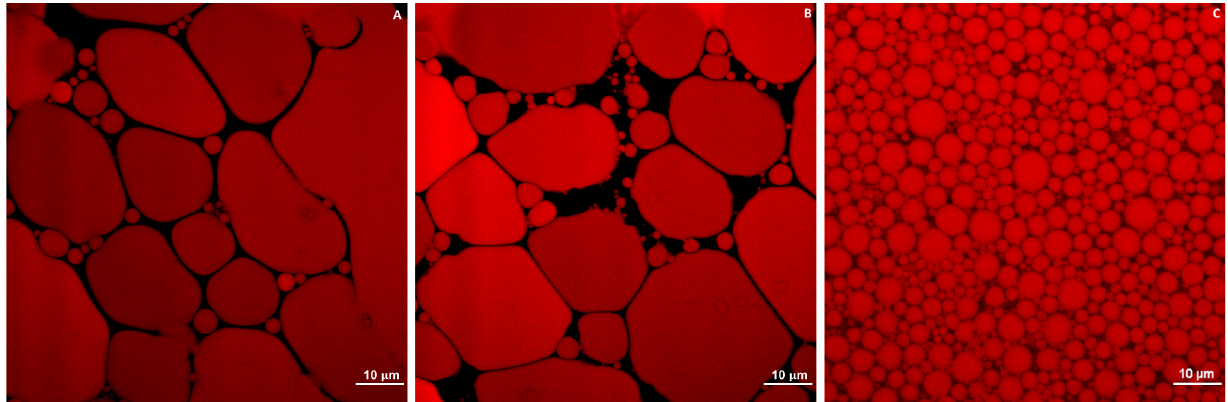
Figure 4. Confocal laser scanning micrographs of mayonnaise and analog prepared with ( A ) freeze-dried aquafaba, ( B ) spray-dried aquafaba, and ( C ) egg yolk. All images were captured at a working magnification of 600× with a 5 times digital zoom. Oil phase was stained with 0.01 wt.% Nile red. Scale bars represent 10 µm.